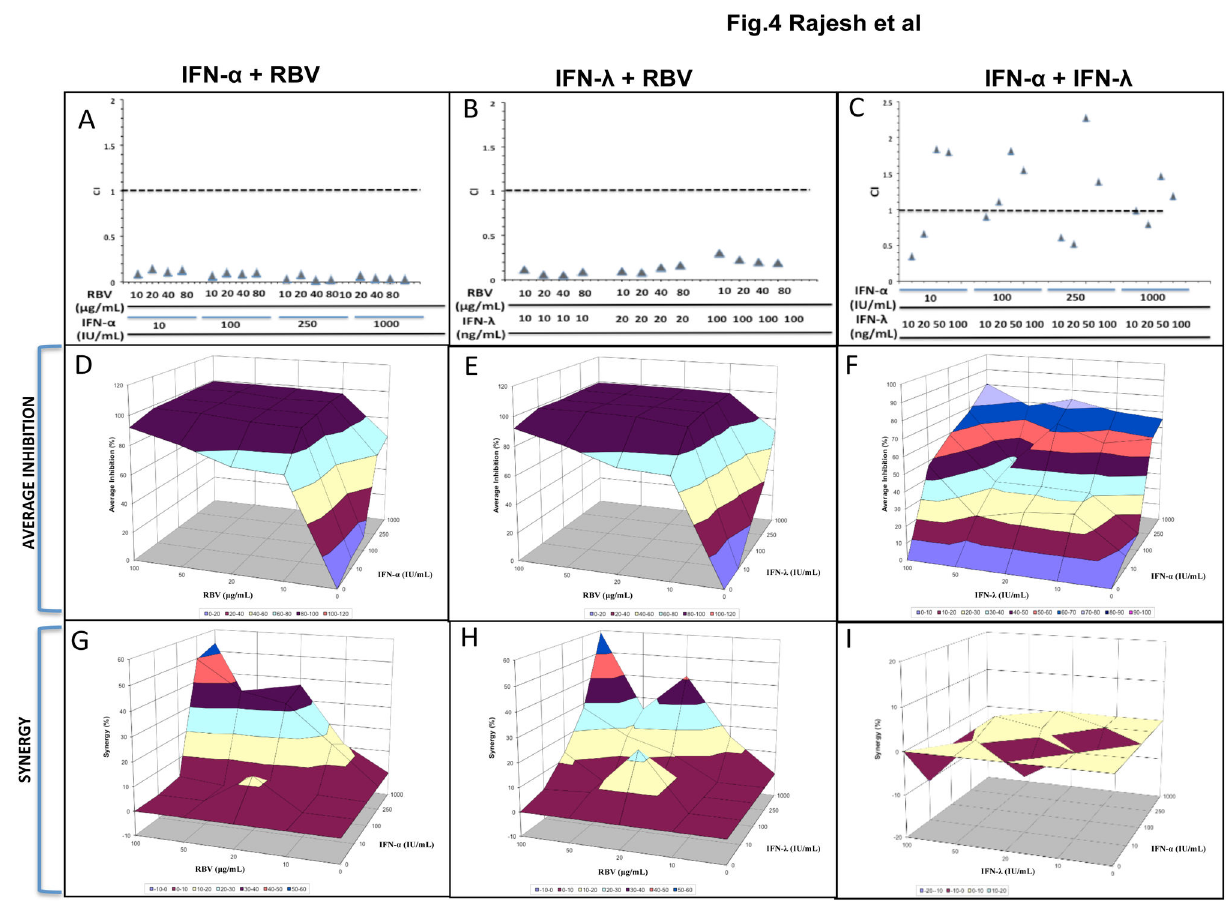
Figure 4. Analysis for synergistic effect of IFN-α + IFN-λ, IFN-α + RBV, and IFN-λ + RBV using Calcusyn and MacSynergyII software. ( A ) CalcuSyn software analysis show that IFN-α + RBV combination treatment has a very strong synergy antiviral activity against HCV IRES mediated inhibition with combination index, CI<1. ( B ) IFN-λ + RBV combination treatment also has a very strong synergy antiviral activity with CI<1. ( C ) IFN-α + IFN-λ treatment are either additive or slightly antagonistic. Three dimensional inhibition plots of ( D ) IFN-α + RBV, ( E ) IFN-λ + RBV and ( F ) IFN-α + IFN-λ treatment against HCV IRES mediated inhibition of Rluc at 95% confidence interval synergy plot. Three dimensional synergy plot of ( G ) IFN-α + RBV, ( H ) IFN-λ + RBV, and ( I ) IFN-λ + IFN-